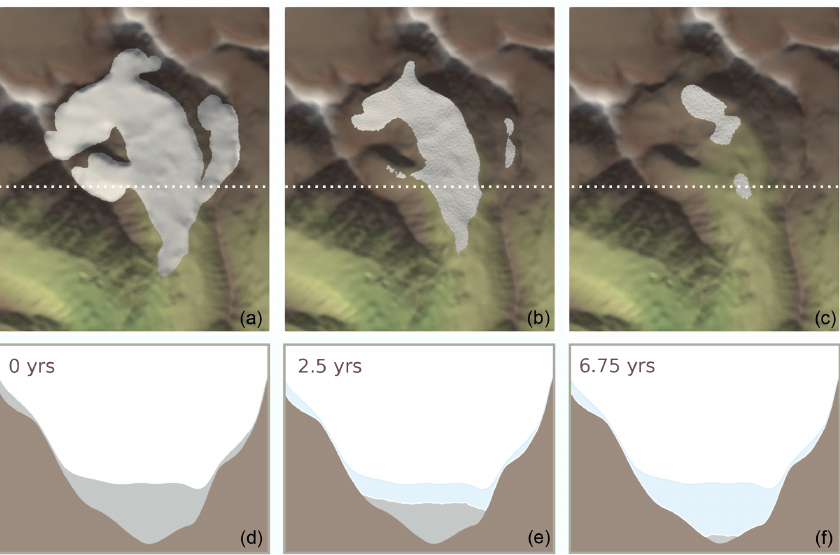
Figure 10. Random input fields test. The view of the surface elevation that exceeds the bed constraint in white and bed constraint in colour at (a) the start of the simulation, at (b) 2 . 5 and (c) 6 . 75 years. Corresponding profiles of surface elevation (silver), bed constraint (brown) and initial surface elevation (light blue) in (d)–(f) . The elevation on the y axis is shown on a 4:1 scale and is thus quite